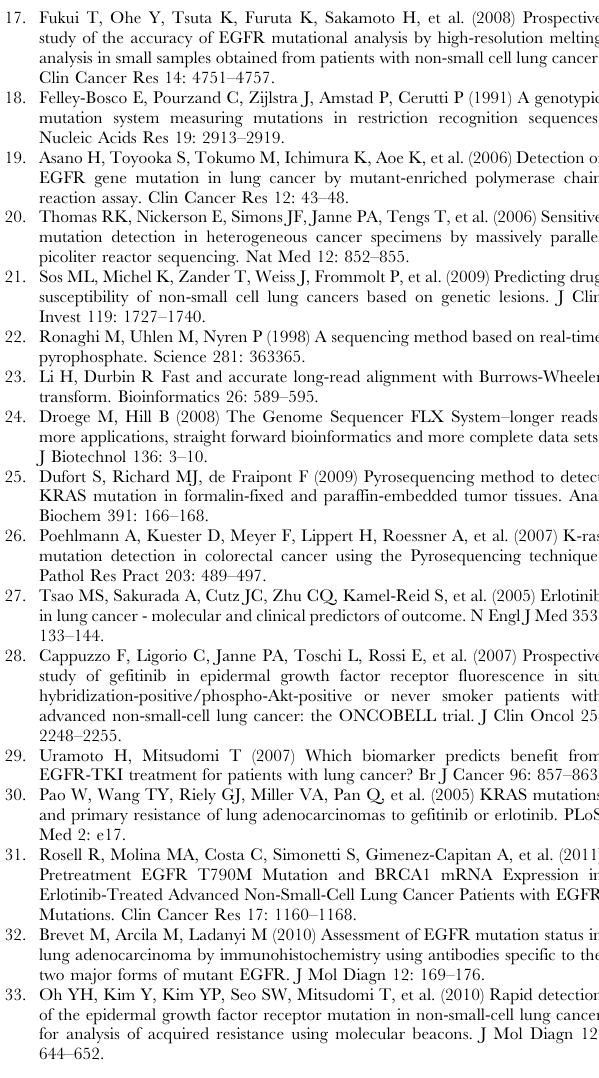
Table S4 EGFR and KRAS gene specific primers for massively parallel sequencing. Primer pairs for massively parallel sequencing of EGFR exon 18–21 and KRAS exon 2 and 3 are depicted. Table S5 Comparison of mutation detection perfor- mance between sequencing methods. Sensitivity of EGFR